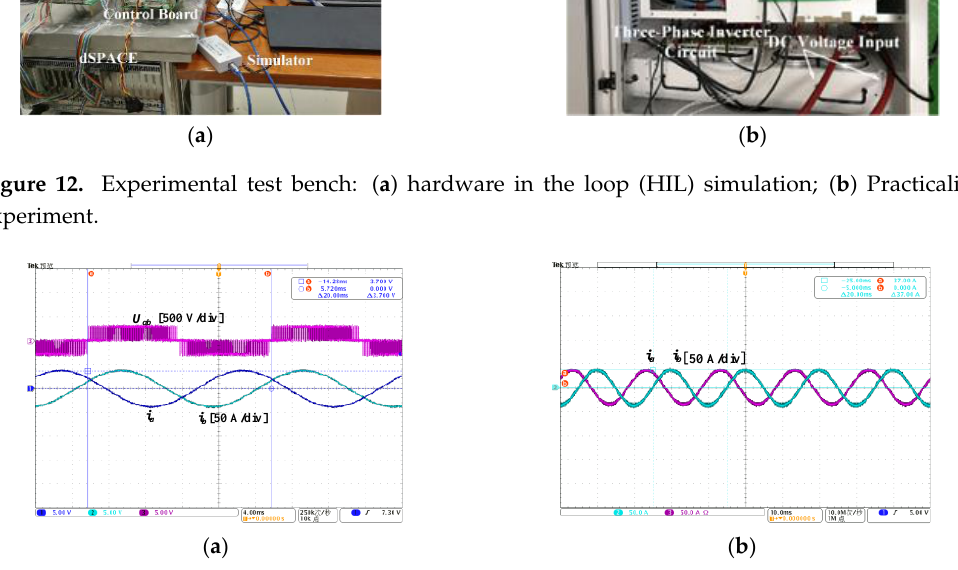
Fig ure 13 . Three-phase load current waveform: ( a ) HIL simulation; ( b ) practicality experiment.